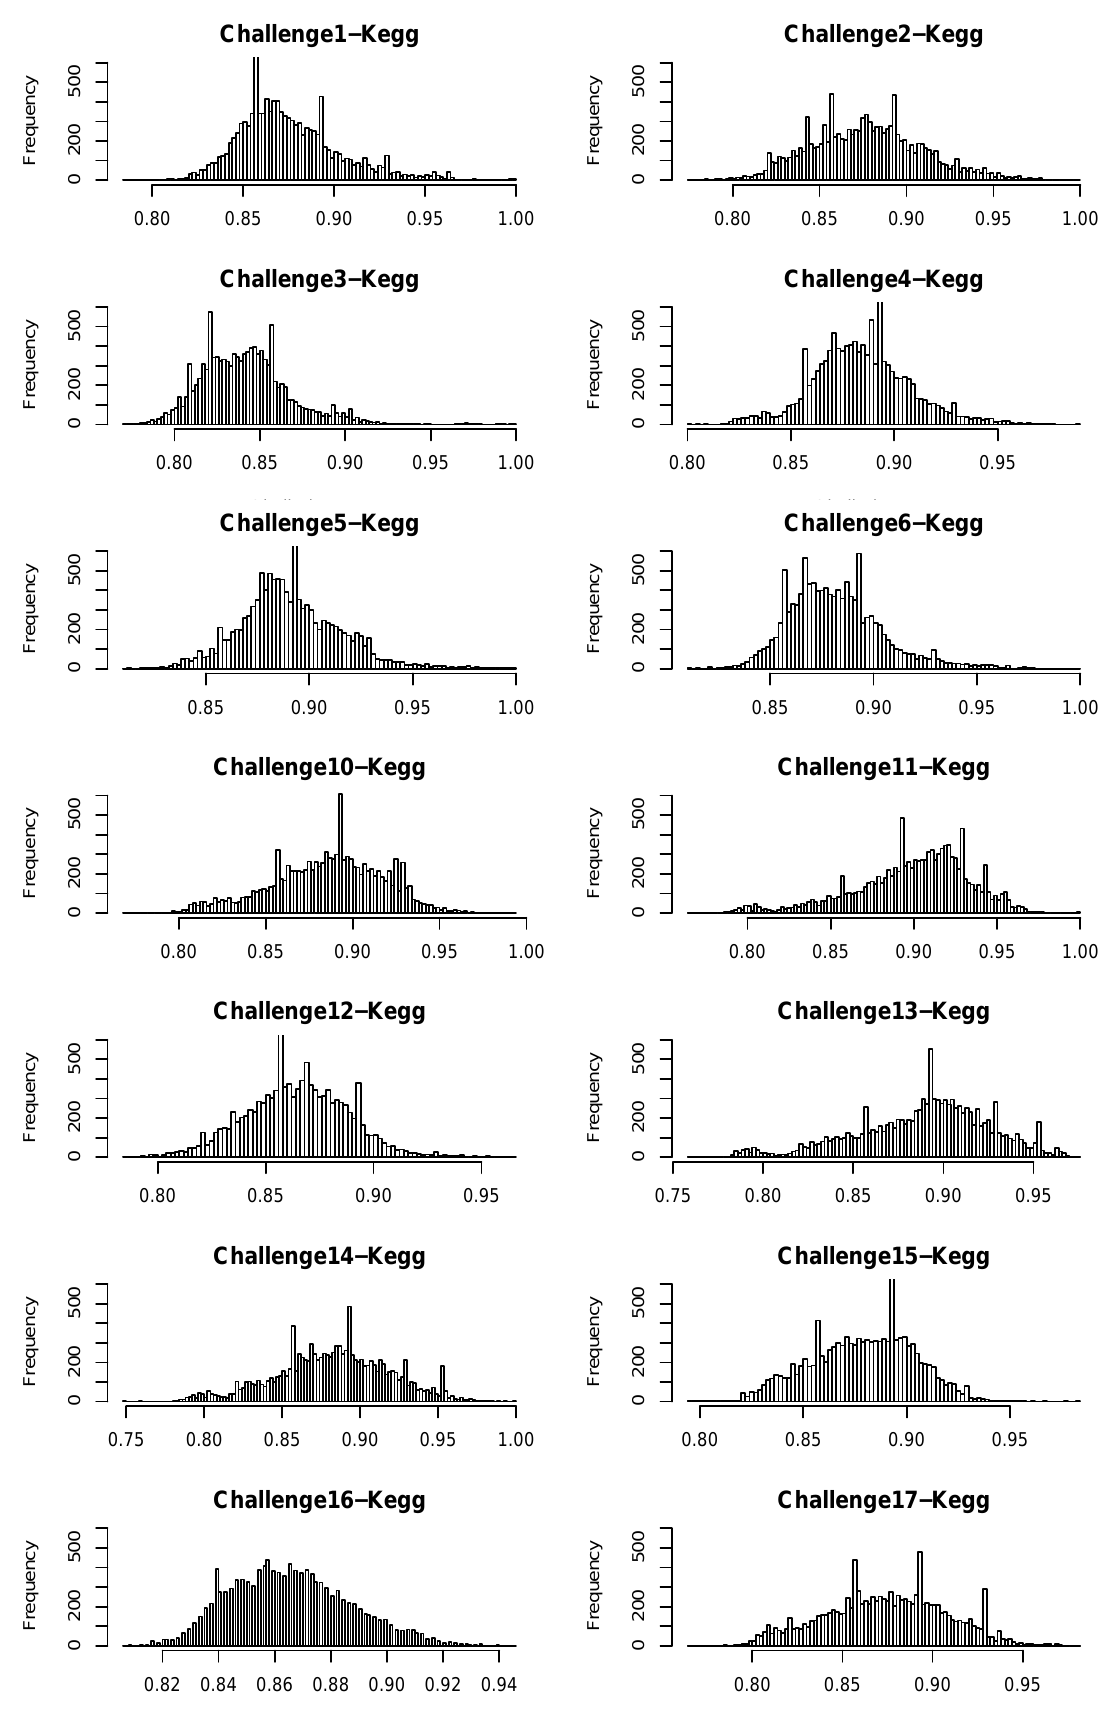
Figure A2. Distribution of similarity scores between challenge molecules and molecules in the KEGG compound